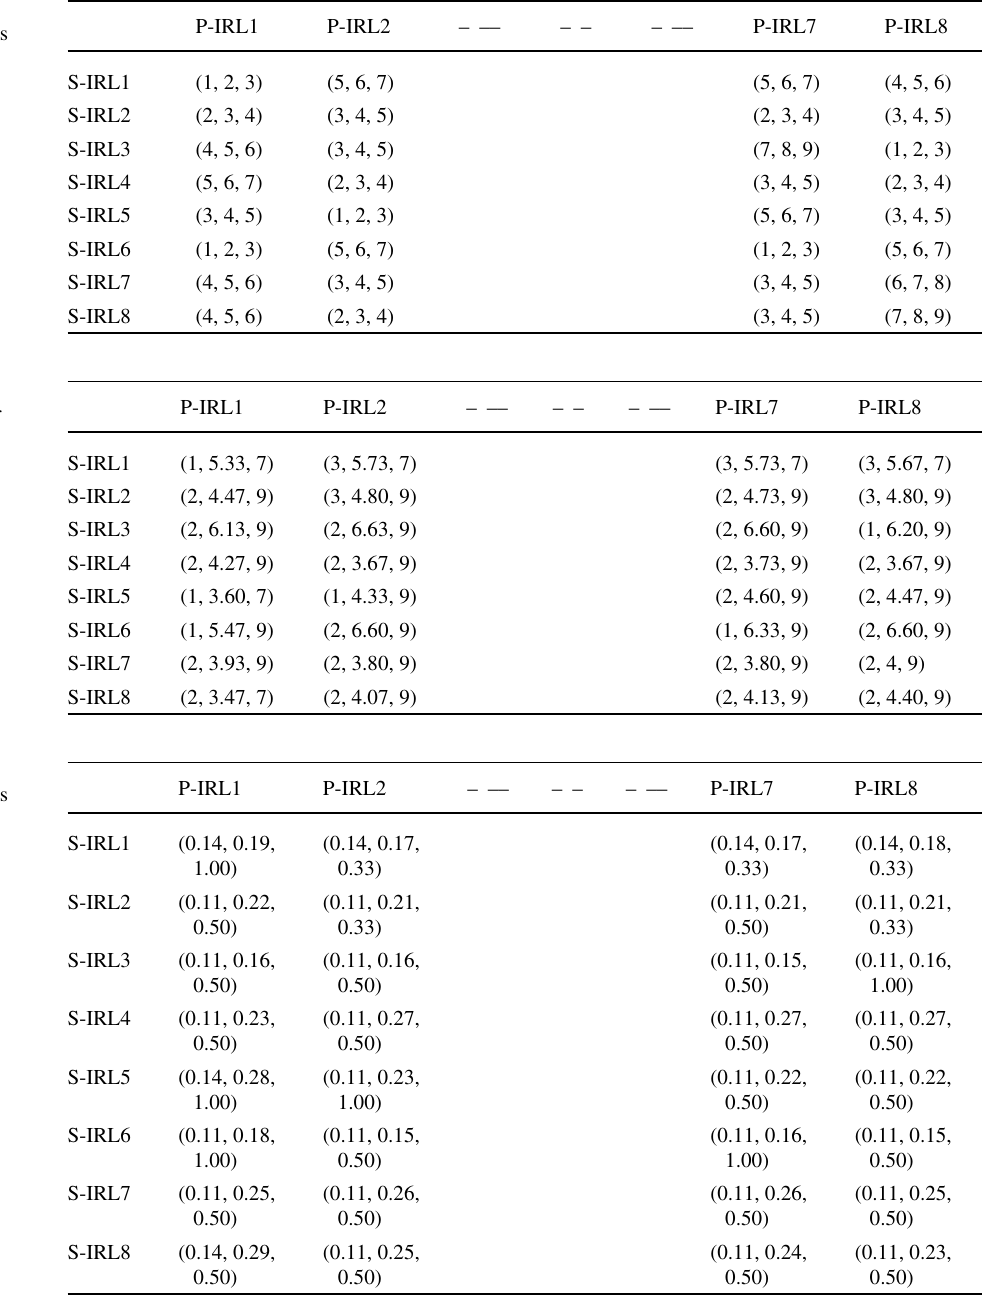
Table 9 Fuzzy TOPSIS evaluation matrix for solutions (EXPERT 1)